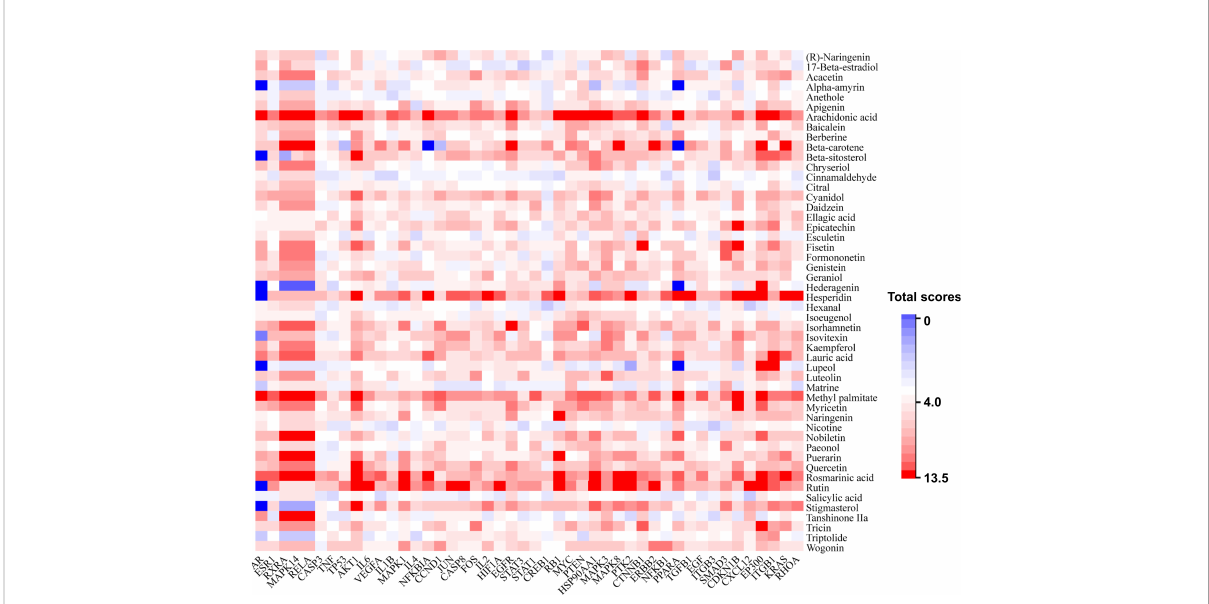
FIGURE 6 The binding scores between 46 targets (x axis) and the top 50 chemical components ranked by node degree value (y axis). Colors indicated different scores. (red, higher than 4.0; blue, less than